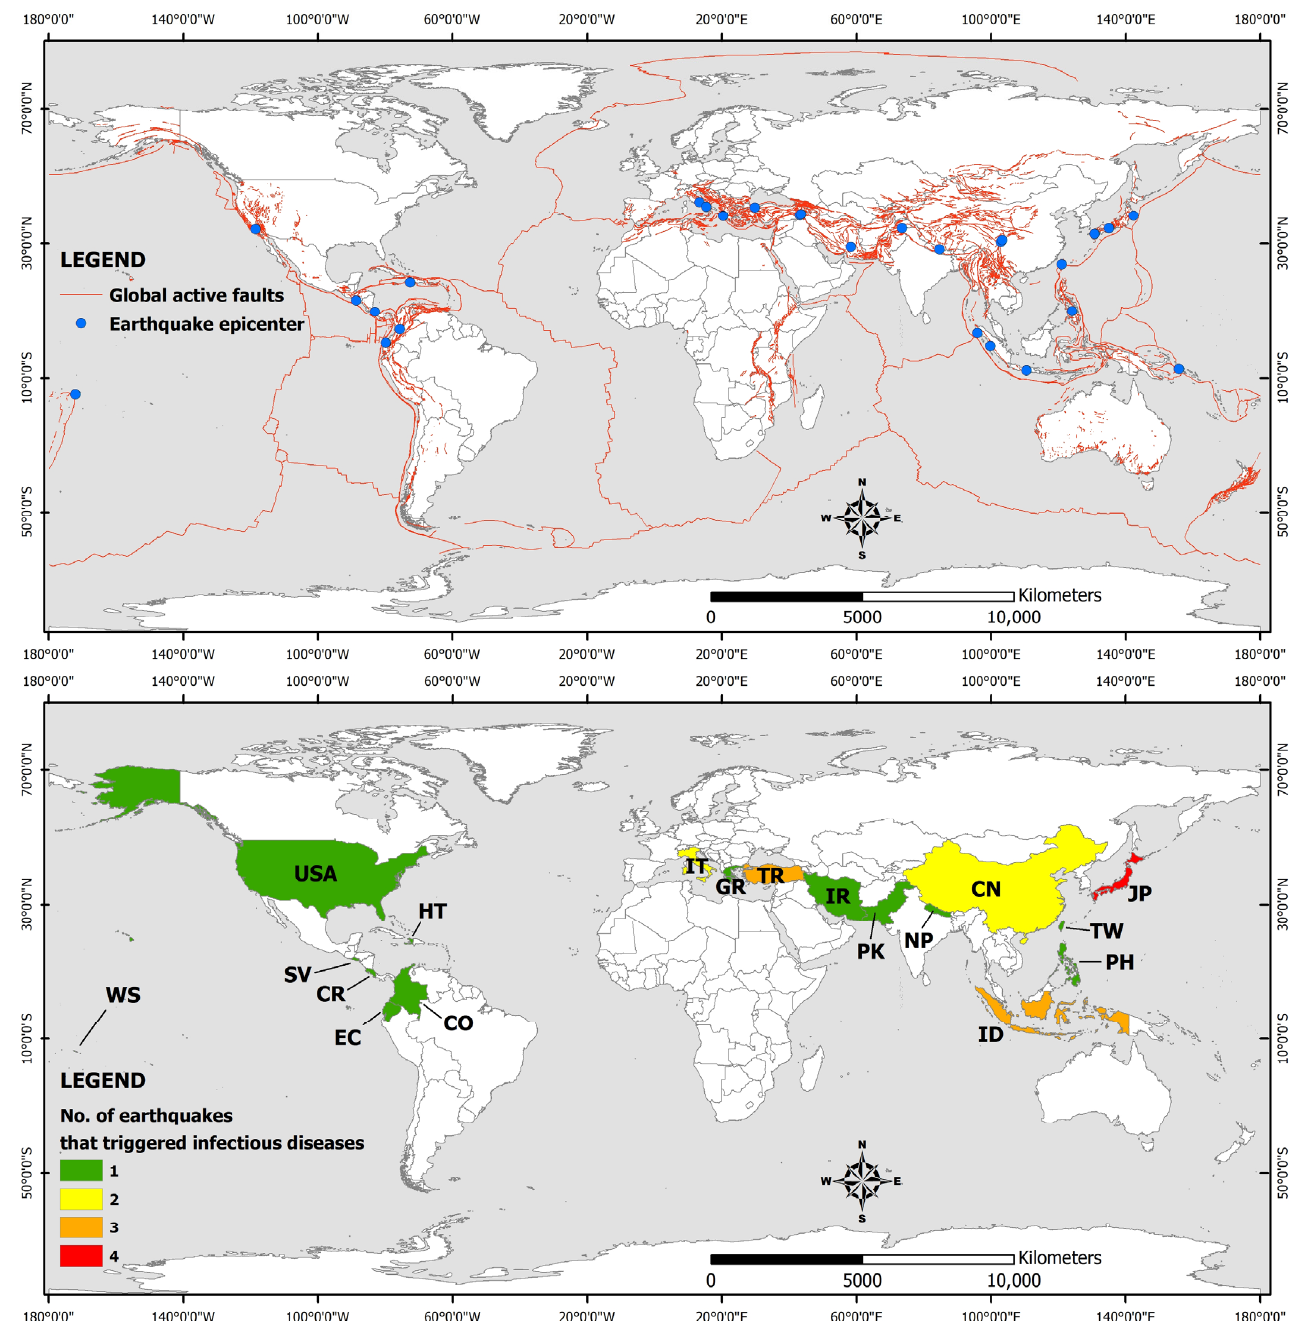
Figure 1. ( Up ) Map illustrating the active faults of the world and the epicenters of the earthquakes included in the study. ( Down ) Distribution of the countries affected by earthquake-triggered infectious diseases. The affected countries are located within the red fault zones. The global fault zones are from Styron and Pagani [67]. WS: Samoa, USA: United States, HT: Haiti, SV: El Salvador, CR: